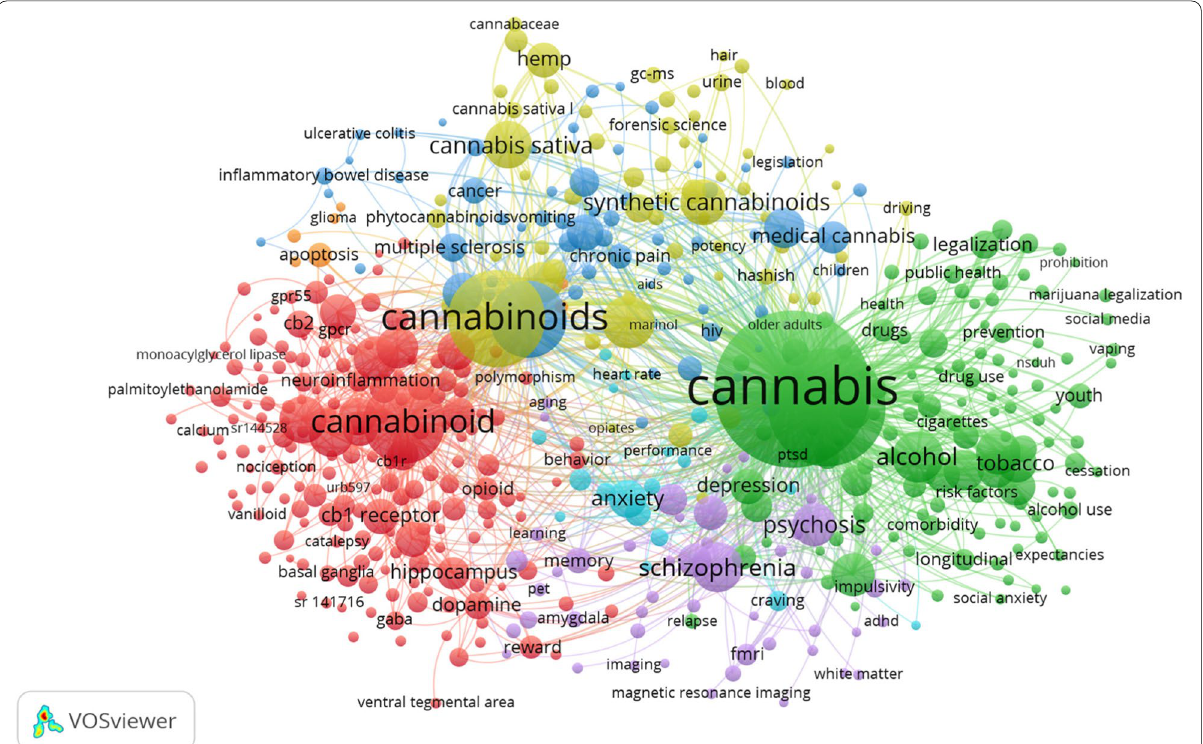
Fig. 4 Co-occurrence analysis of the 500 most frequent author keywords. The most frequently used keywords appear as larger nodes with larger text. Each cluster of highly related keywords is displayed using a different colour to facilitate categorization. Data was collected from Scopus, and the bibliometric web was generated using the VOSviewer